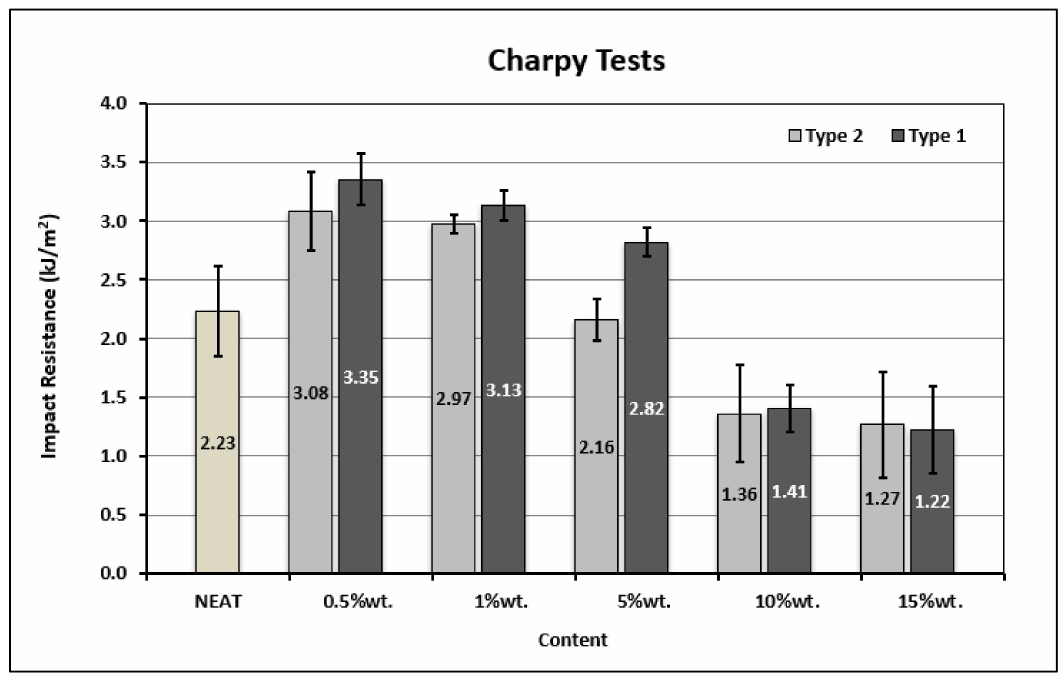
Figure 4. Impact properties of the nano-reinforced